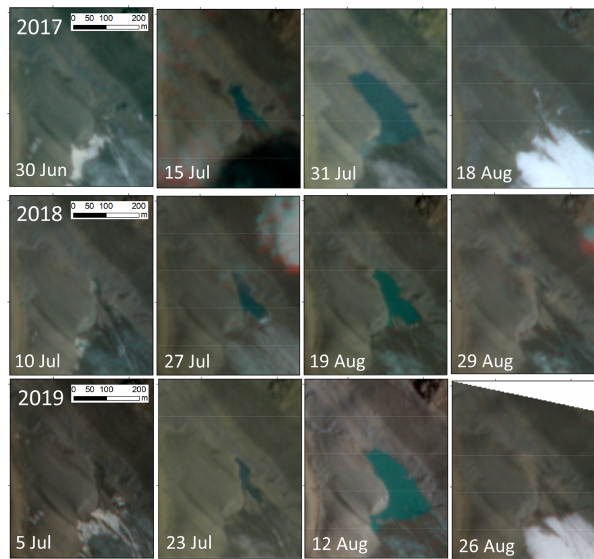
Figure 4. Time sequence of satellite images (PlanetScope) of Ko- rumdu lake in 2017, 2018, and 2019.